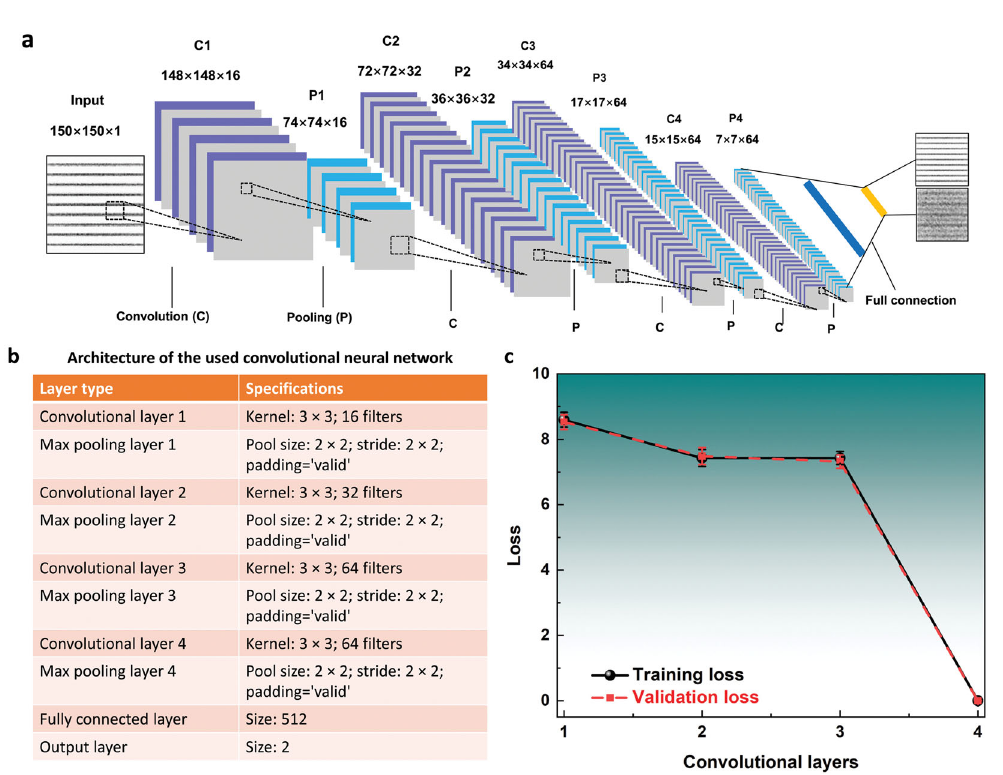
Fig. 3 Proposed CNN con fi guration. a The architecture of CNN for identifying ordered structures; b the detailed architecture of each layer; c the fi nal loss values of training and validation after 7 epochs of different CNN structures including different convolutional (plus max pooling) layers as shown in a only using simulated data.